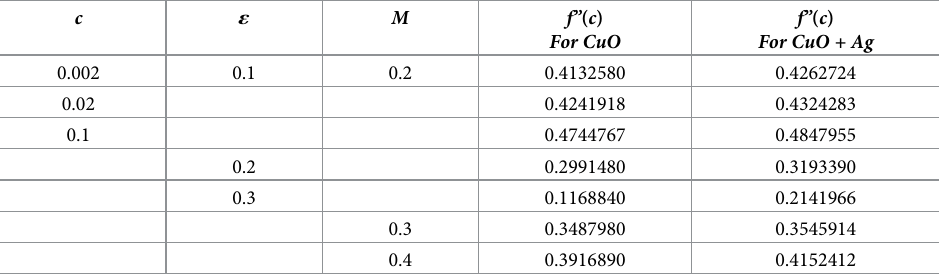
Table 4. Impact upon skin friction coefficient f” ( c ) when Pr = 7, ϕ 1 = 0.02 = ϕ 2 , m = 0.4.